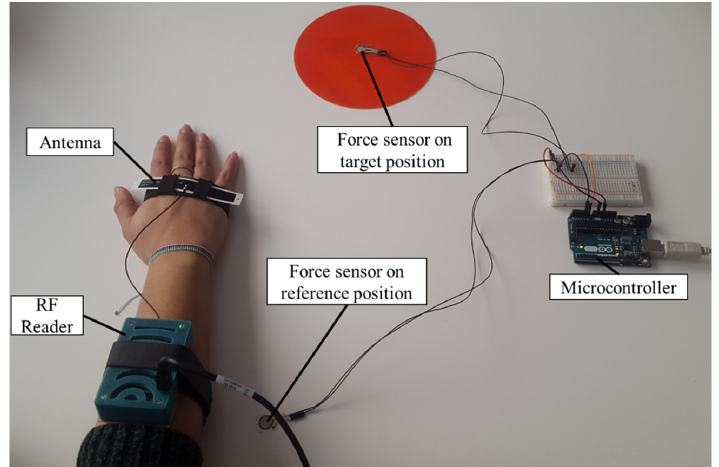
Figure 4. The experimental setup for the comparison of the radiofrequency (RF) signal al the force sensors’ signal. The target and reference positions, the RF system and the microcontroller are depicted. Each task was performed 5 times by each participant. A total number of 4 participants performed the tests. The start and stop time were extracted from the force signal. In this case, the starting time was considered as the first sample for which the force value was below 50% of the maximum value recorded during the trial by the force sensor placed in the starting position. The stopping time was counted as the first sample for which the force value was over 50% of the maximum value recorded during the trial by the force sensor placed in the final position. The start and stop times detected through the force sensors and the RF signal were compared by computing the time difference for each point between the two systems. A sample of the obtained results is shown in Figure 5.